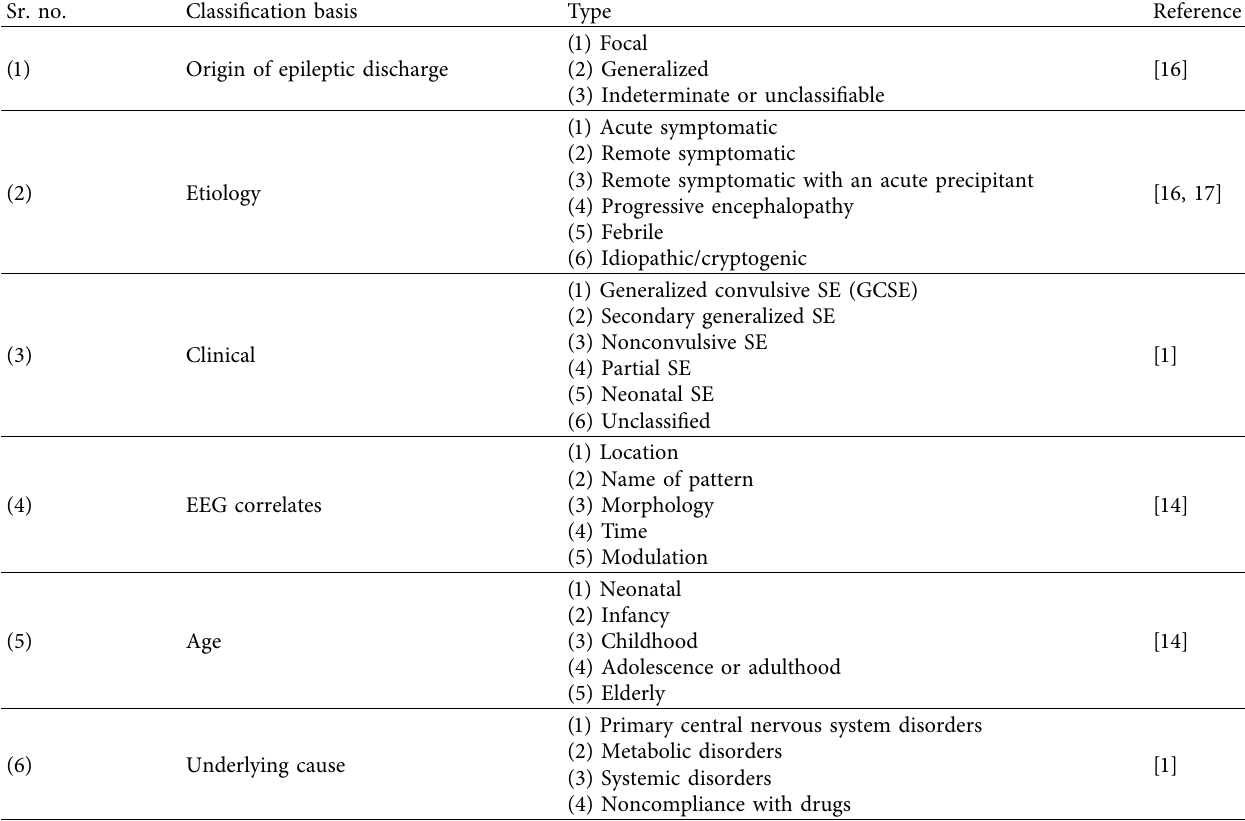
Table 2: Classification of SE based on different